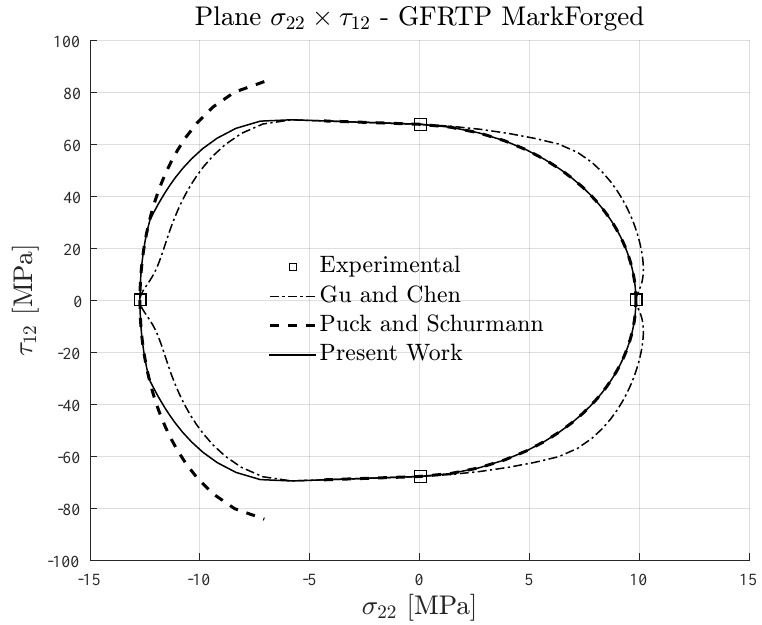
Figure 10. Failure envelopes on the stress space σ 22 × τ 12 for 3D-printed continuous glass-fiber reinforced thermoplastic lamina. Inclination parameter p c ⊥⊥ = 0.25 for Puck and Schürmann and Expanded Puck and Schürmann.